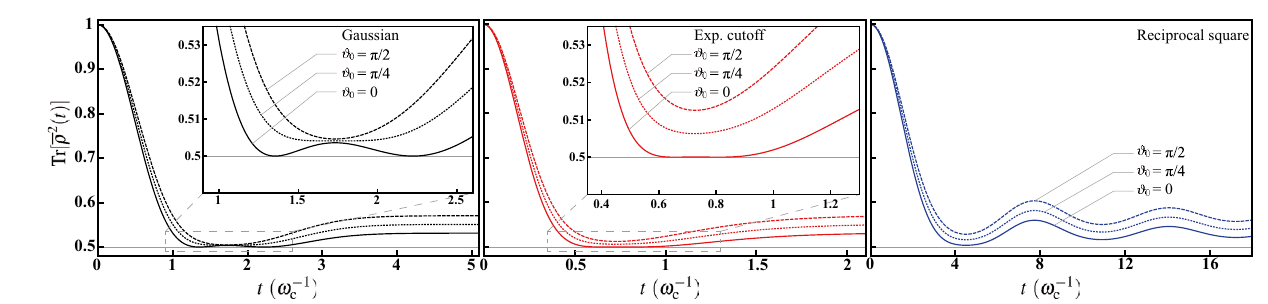
Figure 2. Decoherence under the HE with bagel-shaped geometry. ( a ) Visualization of the solid angular part �(θ , φ) π − 2 sin θ of the probability distribution. The bagel-shaped geometry exhibits the azimuthal and = reflectional symmetries simultaneously; meanwhile, this leads to the regime The decay rates γ x ( t ) (solid curves) and γ z ( t ) (dashed curves) for the Gaussian (black) and the exponential cutoff (red) radial functions. Each γ x ( t ) exhibits two singularities and finally approaches zero asymptotically. ( c ) The decay rates γ x ( t ) (solid curves) and γ z ( t ) (dashed curves) for the reciprocal square radial function. γ x ( t ) shows a similar oscillating behavior; while γ z ( t ) possesses more zeros. Additionally, the amplitude of γ x ( t ) is larger than γ z ( t ) , reflecting the relationship > n 2 n 2 z (cid:30) � . x (cid:30) � (cid:31) (cid:31)